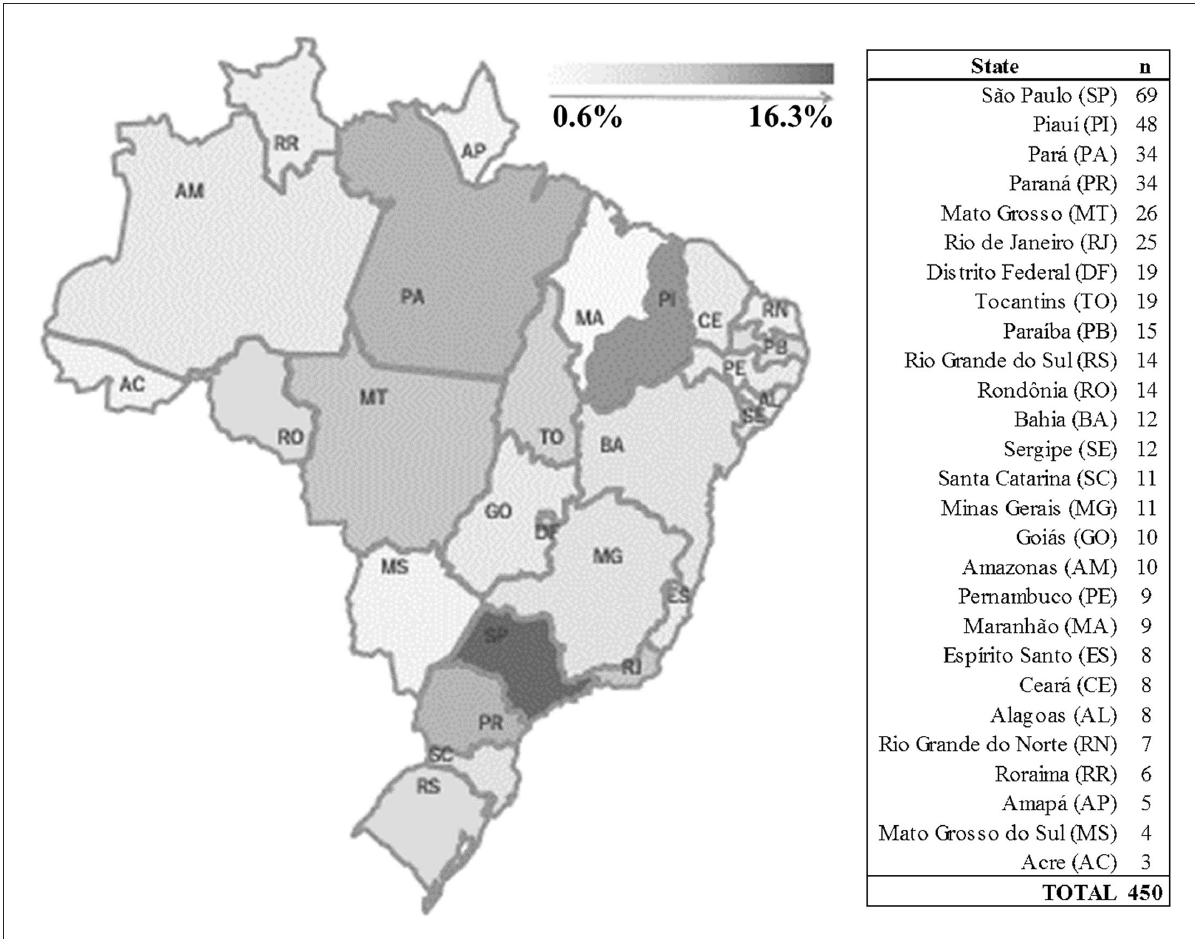
FIGURE1 Sample divided by Brazilian